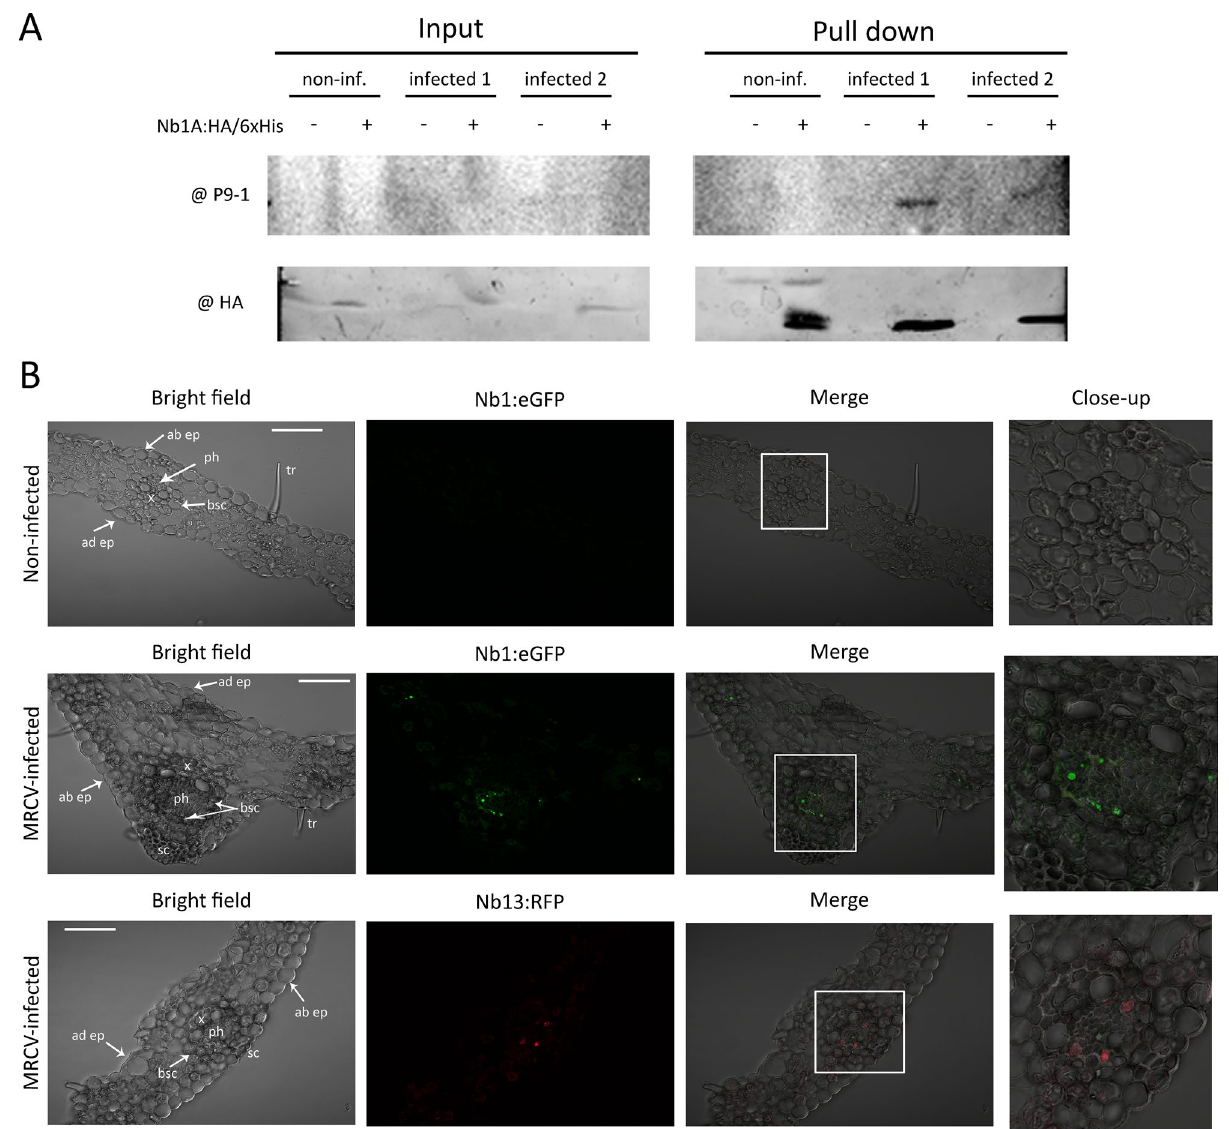
Figure 5. Immunodetection of MRCV P9-1 in infected plants using Nbs. ( A ) Assessment of the use of His-tagged Nb1 as a tool to pull down P9-1 present in infected maize plants. Total protein extracts from one non-infected (non-inf.) and two MRCV-infected (infected 1 and 2) maize plant leaves were incubated with 1 ug of purified Nb1:HA/6xHis and Ni–NTA resin. Extract samples before (input control) and after the pull-down were analysed. The presence of MRCV P9-1 (upper panel) was evidenced by western blot after a 10% SDS- PAGE using guinea pig anti-P9-1 sera as primary antibody and anti-guinea pig-HRP as secondary antibody. In turn, the presence of Nb1:HA/6xHis (lower panel) was detected by western blot after a 12% SDS-PAGE using mouse anti-HA as primary antibody and anti-mouse-AP as secondary antibody. Blots from ( A ) were cropped and grouped to simplify the Figure. ( B ) Confocal images after immunolocalisation of MRCV P9-1 in wheat leaf sections. Tissues were incubated with Nb1:eGFP or Nb13:RFP. Top panels correspond to non-infected plant samples whereas middle and bottom panels correspond to MRCV-infected samples at 35 days post-infection. In each case, images of the bright fields, green or red channels, the merging images and close-ups are shown. Phloem (ph), xylem (x), bundle sheath cells (bsc), sclerenchyma (sc), adaxial (ad) and abaxial (ab) epidermis (ep), and trichomes (tr) are marked. Scale bars = 100